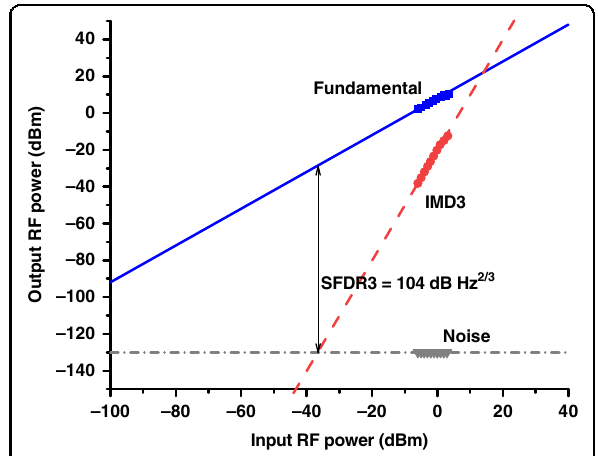
Fig. 14 Example of the SFDR3 measurement